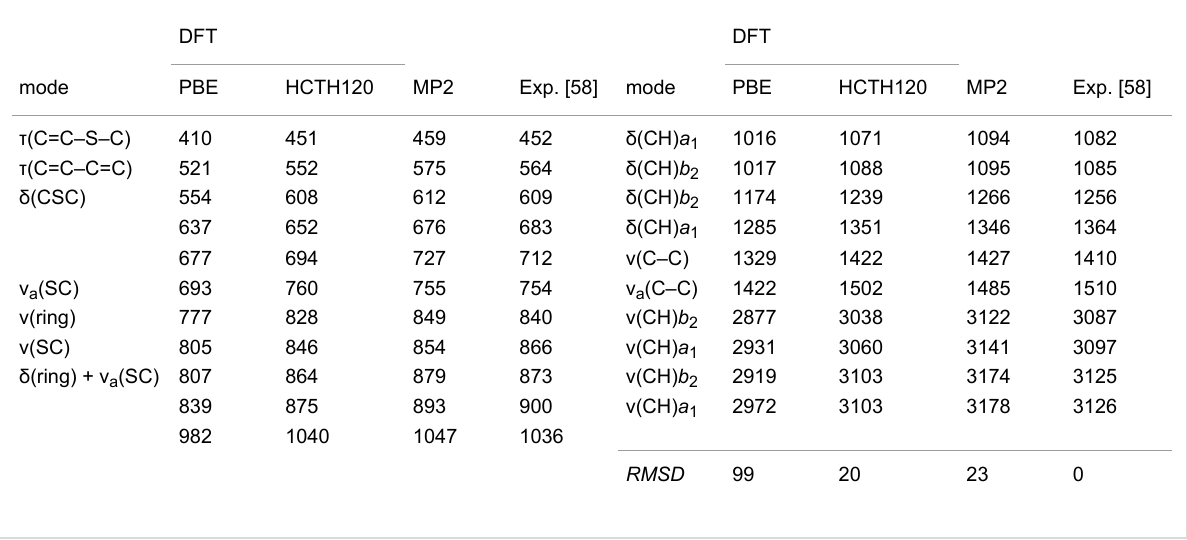
Table 4: Anharmonic frequencies of the fundamental vibrational modes of thiophene in the gas phase (in cm − 1 ). The mode assignment convention is: ν – stretching, δ – bending, τ – twisting. The subscript “a” denotes an antisymmetric mode. The CH-stretching and CH-bending modes are labelled according to their irreducible symmetry representation in C 2 ν